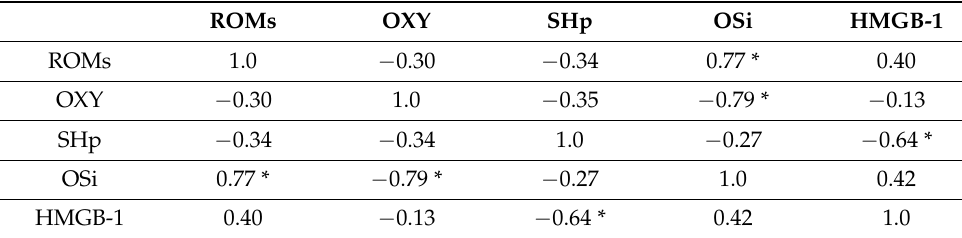
Table 4. Correlation between different HGMB-1 and oxidative stress variables in LEISH Group dogs (Spearman rank order) (* p < 0.05). ROMs OXY SHp OSi HMGB-1 ROMs